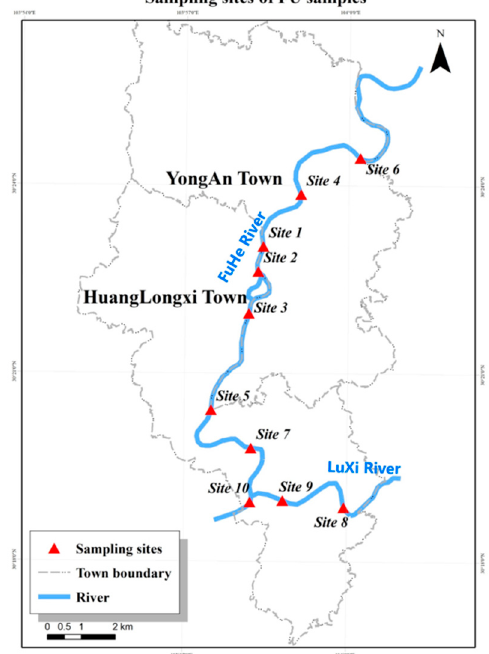
Figure 1. FU dataset sampling sites. The sequence of sampling sites shall be sorted according to the sampling time. The number of samples collected from each site are: Site 1 collected 10 samples, Site 2 collected 5 samples, Site 3 collected 3 samples, Site 4 collected 3 samples, Site 5 collected 3 samples, Site 6 collected 3 samples, Site 7 collected 8 samples, Site 8 collected 2 samples, Site 9 collected 2 samples, and Site 10 collected 10 samples. The number of samples shall be determined according to the actual situation of the sampling sites.